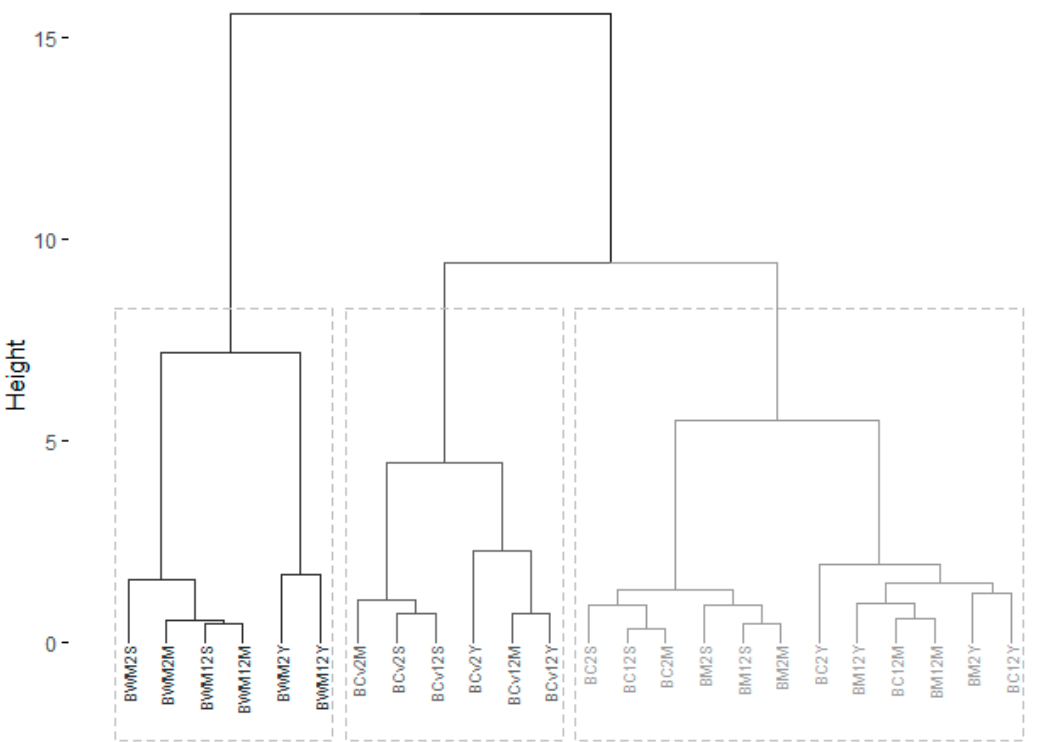
Figure 2. Dendogram for cluster analysis (BWM2S: 75% FC + 25% FCv wholemeal mixed flour/2 h fermentation/sourdough; BWM2M: 75% FC + 25% FCv wholemeal mixed flour/2 h fermenta- tion/mixed leavening; BWM2Y: 75% FC + 25% FCv wholemeal mixed flour/2 h fermentation/yeast; BWM12S: 75% FC + 25% FCv wholemeal mixed flour/12 h fermentation/sourdough; BWM12M: 75% FC + 25% FCv wholemeal mixed flour/12 h fermentation/mixed leavening; BWM12Y: 75% FC + 25% FCv wholemeal mixed flour/12 h fermentation/yeast; BM2S: 75% FC + 25% FCv refined mixed flour/2 h fermentation/sourdough; BM2M: 75% FC + 25% FCv refined mixed flour/2 h fer- mentation/mixed leavening; BM2Y: 75% FC + 25% FCv refined mixed flour/2 h fermentation/yeast; BM12S: 75% FC + 25% FCv refined mixed flour/12 h fermentation/sourdough; BM12M: 75% FC + 25% FCv refined mixed flour/12 h fermentation/mixed leavening; BM12Y: 75% FC + 25% FCv re- fined mixed flour/12 h fermentation/yeast; BCv2S: 100% refined ‘Caaveiro’ variety/2 h fermenta- tion/sourdough; BCv2M: 100% refined ‘Caaveiro’ variety/2 h fermentation/mixed leavening; BCv2Y: 100% refined ‘Caaveiro’ variety/2 h fermentation/yeast; BCv12S: 100% refined ‘Caaveiro’ variety/12 h fermentation/sourdough; BCv12M: 100% refined ‘Caaveiro’ variety/12 h fermenta- tion/mixed leavening; BCv12Y: 100% refined ‘Caaveiro’ variety/12 h fermentation/yeast; BC2S: 100% refined ‘Castilla’ variety/2 h fermentation/sourdough; BC2M: 100% refined ‘Castilla’ variety/2 h fermentation/mixed leavening; BC2Y: 100% refined ‘Castilla’ variety/2 h fermentation/yeast; BC12S: 100% refined ‘Castilla’ variety/12 h fermentation/sourdough; BC12M: 100% refined ‘Cas- tilla’ variety/12 h fermentation/mixed leavening; BC12Y: 100% refined ‘Castilla’ variety/12 h fer- mentation/yeast ). The correlation between the cophenetic distances and the original distance data was computed to measure how well the cluster tree generated reflected the original data. When the clustering is valid, the linking of objects in the cluster tree should have a strong correlation with the distances between objects in the original distance matrix. The closer the value of the correlation coefficient is to 1, the more accurately the clustering solution reflects the data. Values above 0.75 are considered to be good. For the element dataset of the present study, the value of the correlation coefficient was 0.89. These results show that the variability in terms of the total element content was due to the type and origin of the